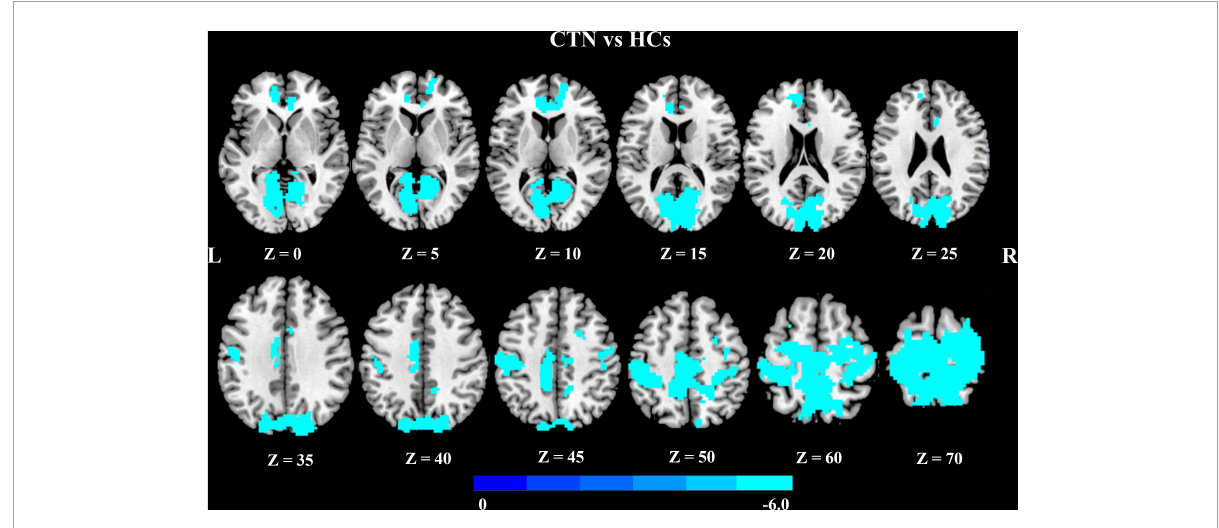
FIGURE2 Altered right lingual gyrus FC in CTN patients. Compared with HCs, the CTN patients exhibited significantly decreased FC between the right lingual gyrus and sensorimotor network, default mode network, and salient network. The significance threshold was set at p < 0.05 with FDR correction (cluster extent threshold > 100 voxels). The cooler colors indicate a lower FC value. The color indicates T -value. FC, functional connectivity; CTN, classic trigeminal neuralgia; HCs, healthy control subjects; FDR, false discovery rate.